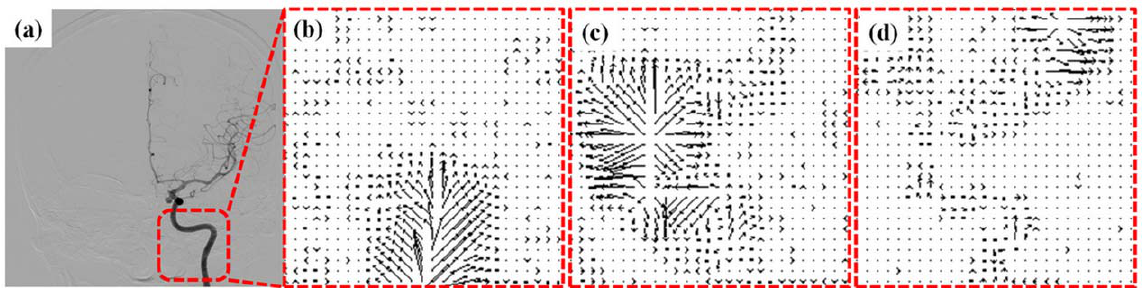
Figure 2. Visualization of the OFM calculation in the blood flow vectors. (a) The original DSA image. The red square represents the region of interest, which shows the visualization. (b–d) shows the blood flow vectors of the initial 3 consecutive time intervals when the contrast agent was injected into the ICA. The time interval was 1/6 s.